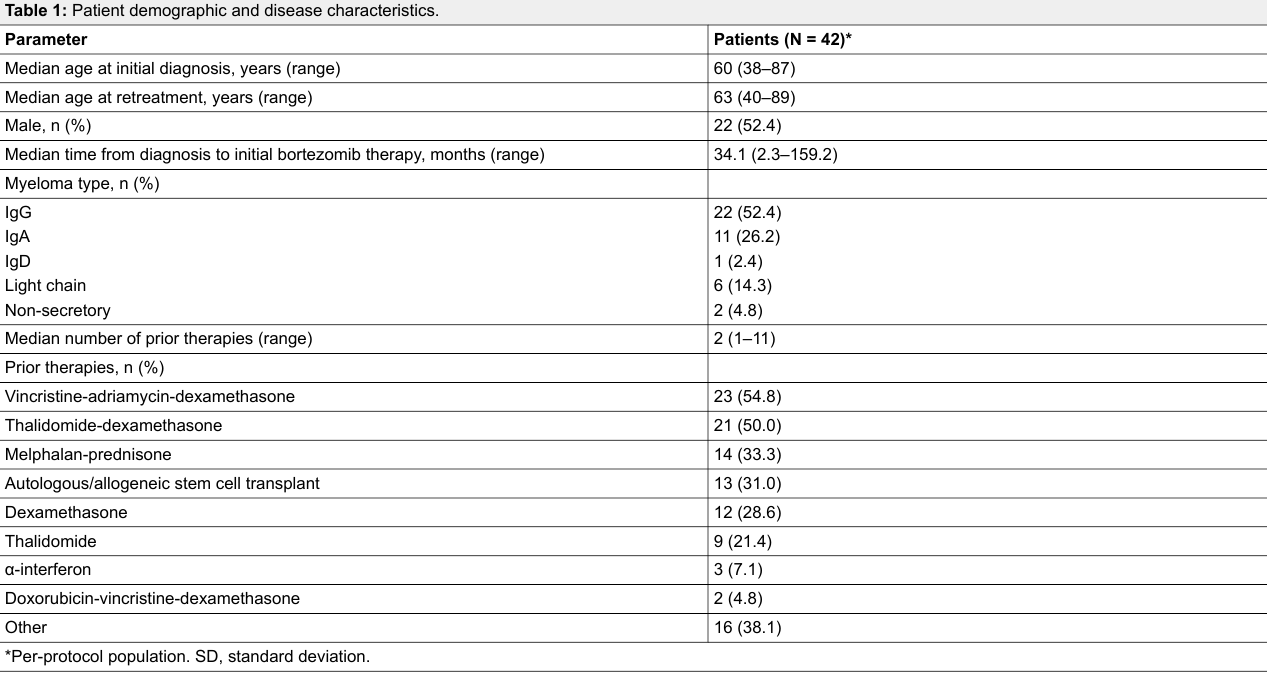
Table 2 : Exposure to bortezomib initial therapy and retreatment, as well as other anti-MM therapy taken concomitantly with bortezomib